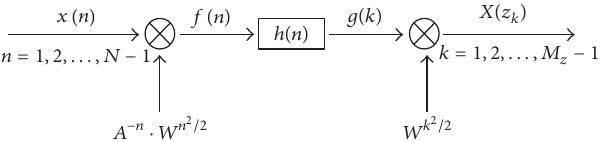
Figure 5: Illustration of steps involved in computing values of the 𝑧 -transform using the